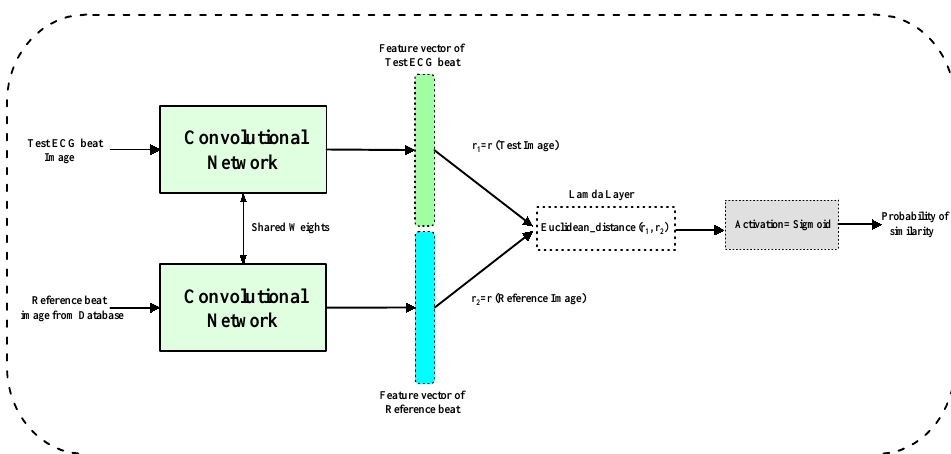
Figure 5. Block diagram of the proposed biometric authentication system during the test